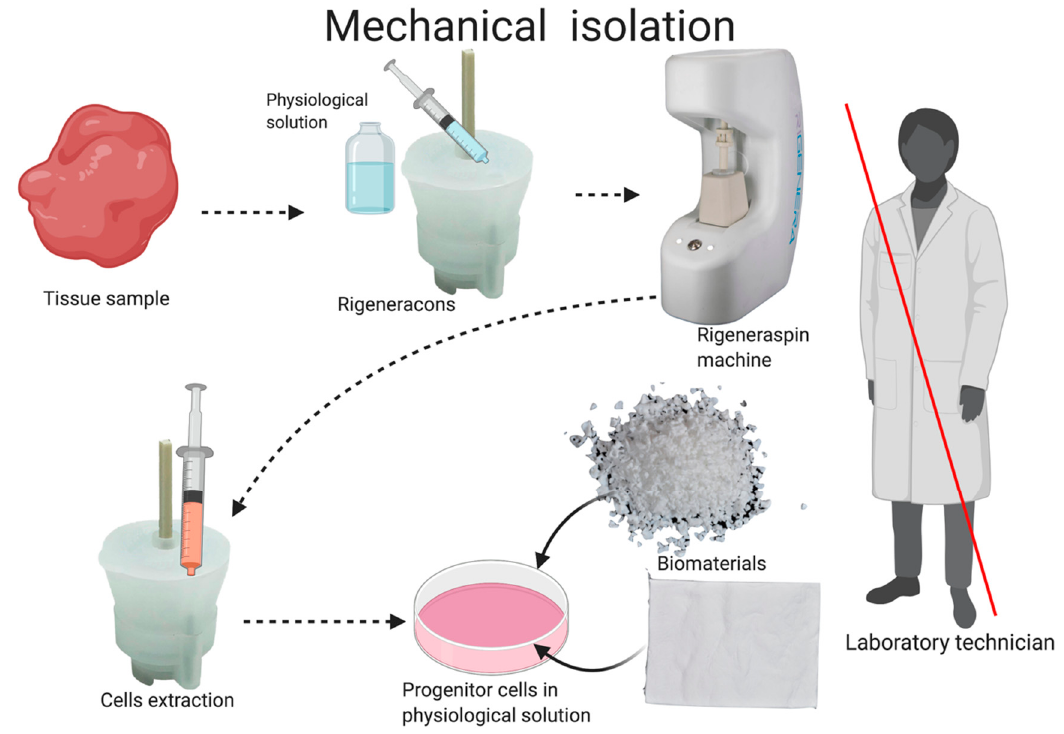
Figure 2. Mechanical isolation of mesenchymal stem cells (MSCs) with the use of a micro-blade grid filter.